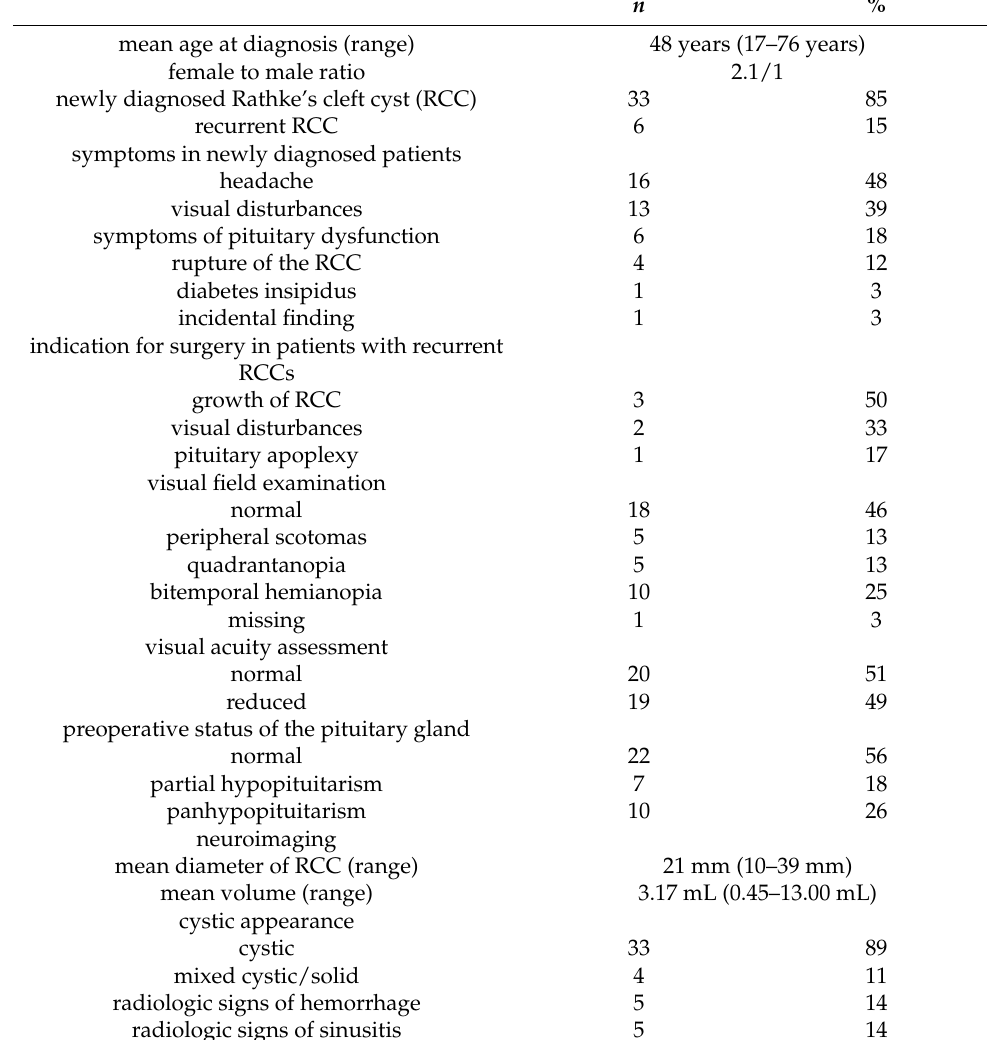
Table 1. Patient